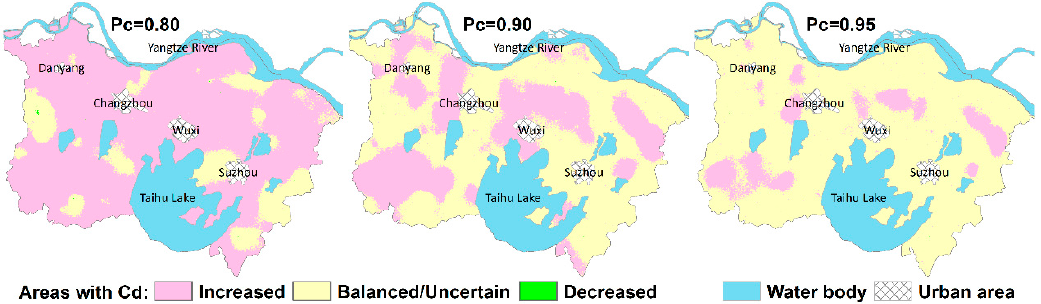
Figure 6. Areas with increased, decreased, and balanced (including uncertain) soil Cd (Cadmium) derived from different critical probabilities.